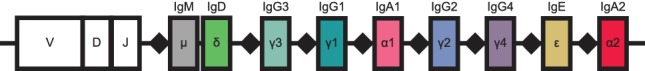
Schematic of human immunoglobulin heavy chain (IGH) locus.Constant region loci are indicated by colored rectangles, with labels and colors corresponding to class, as in Figure 1. Recombination signal sequences are indicated by black diamonds. Because the intervening DNA is looped out and excised during class switch recombination, class switching can only proceed from left to right. This region is located on chromosome 14.